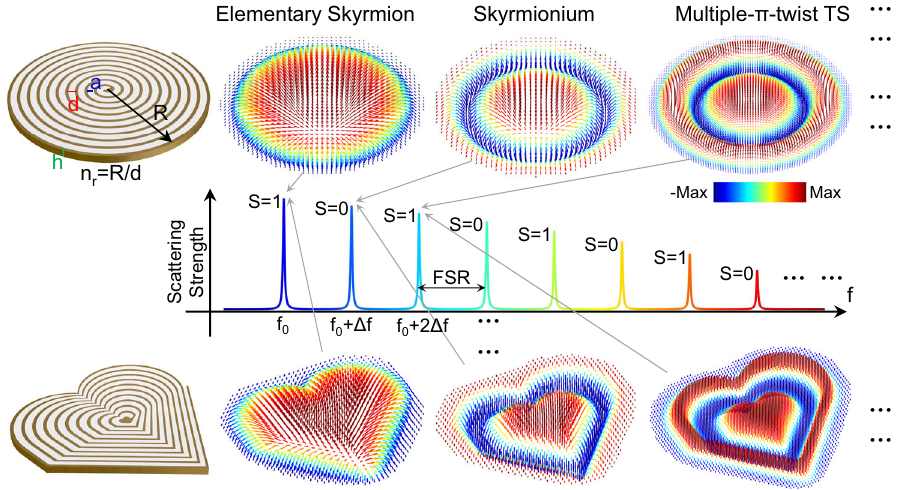
Fig. 1 LSP skyrmions with robust topological features and near-equidistant multi-resonant responses supported by ultrathin space-coiling meta- structures. The space-coiling meta-structures made of a single-armed metallic spiral strip with pitch size d , gap width a , radius R and number of turns n r are shown on the left. The vectorial magnetic fi eld con fi gurations of their supported modes are shown on the right. The space-coiling meta-structures support a train of deeply subwavelength LSP modes with near-equidistant multi-resonant response, whose vectorial magnetic fi eld con fi gurations are characterized by elementary skyrmion, skyrmionium and multiple- π -twist TS, with fundamental resonance frequency f 0 , FSR Δ f , and skyrmion number S = 1 for odd modes and S = 0 for even modes (middle panel). The skyrmion topology is robust against continuous deformations of the geometry, e.g., from round (upper panel) to asymmetric heart shape (lower panel).